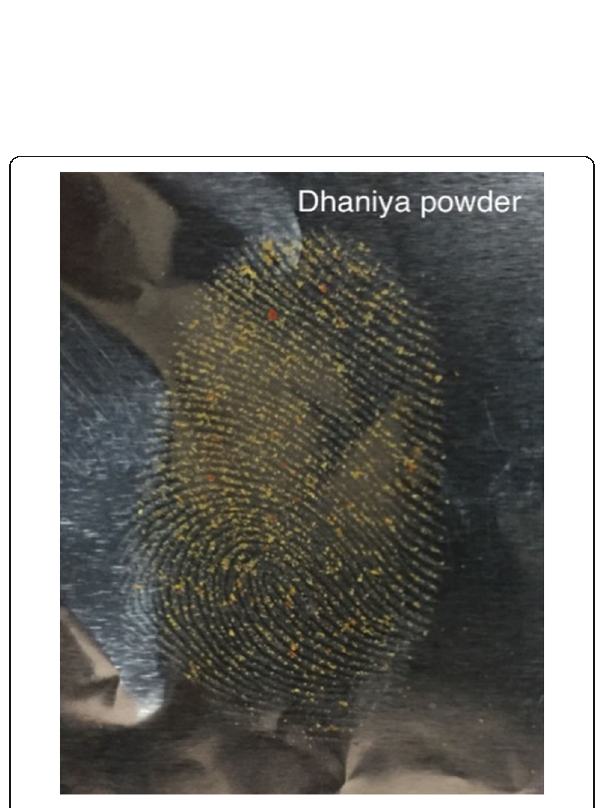
Fig. 16 Development of Latent fingerprint by Coriander powder on Aluminum